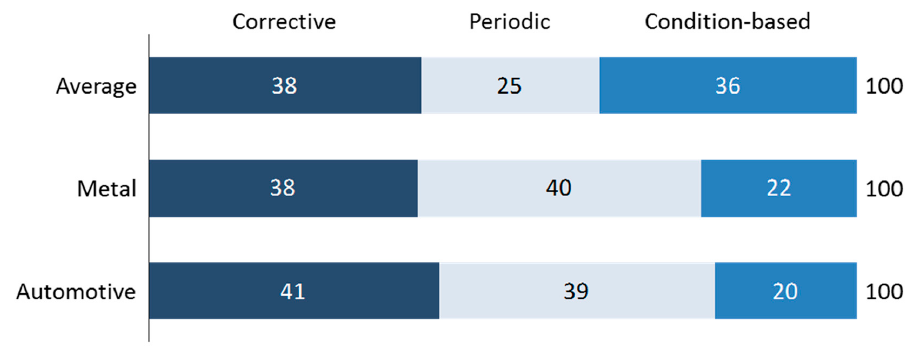
Figure 3. Survey result of 240 European companies on maintenance strategies [11] (p. 41).